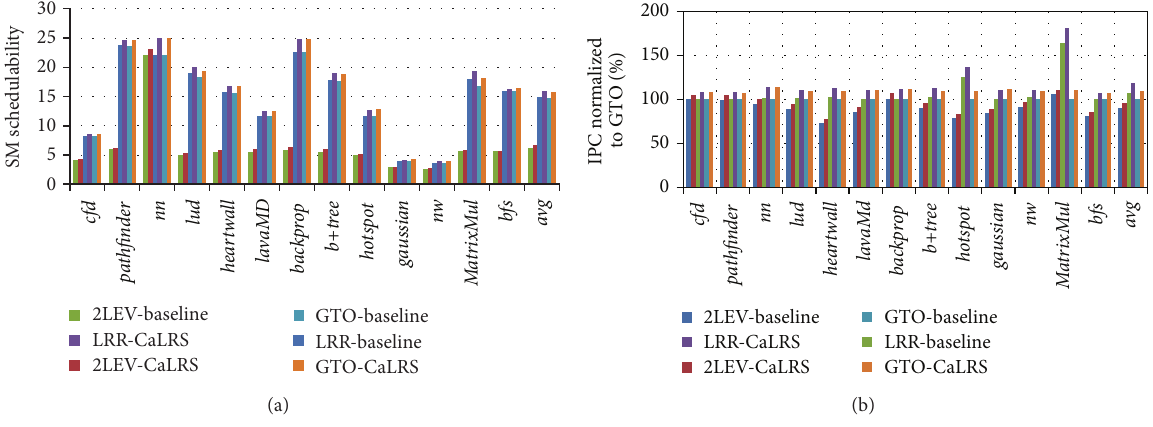
Figure 10: CaLRS performance under various warp scheduling algorithms: (a) SM schedulability, (b) overall IPC.